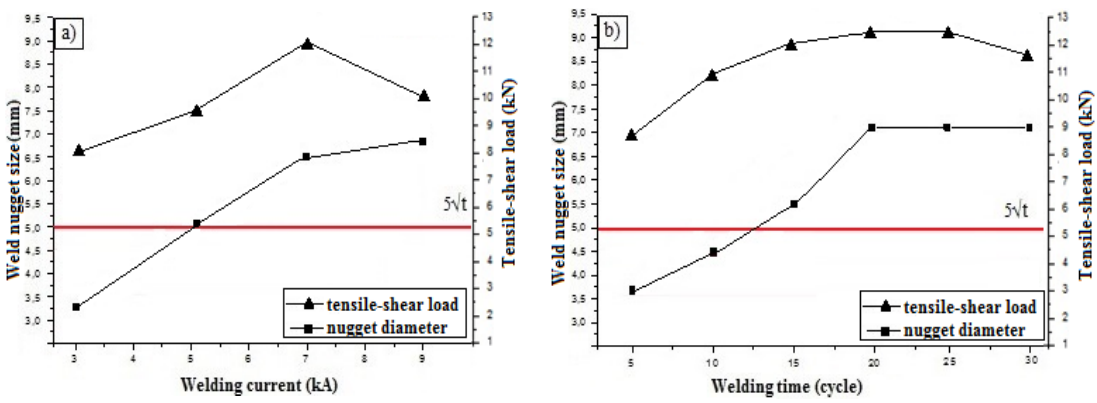
Figure 5. Effect of ( a ) welding current; and ( b ) welding time on weld nugget size and tensile shear strength of